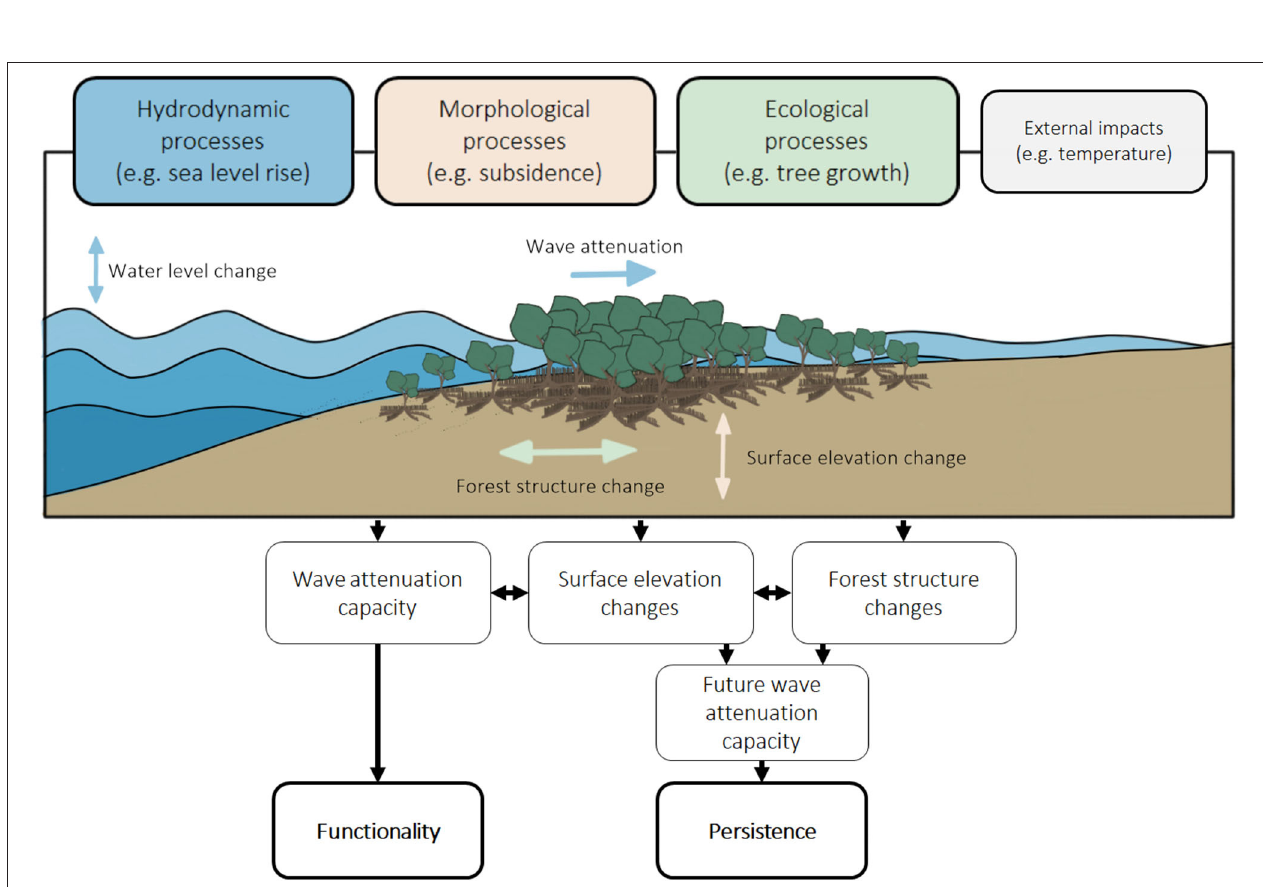
FIGURE 2 | Interacting hydrodynamic, morphological and ecological processes in mangroves determine their functionality and persistence. These interactions are also affected by external impacts.